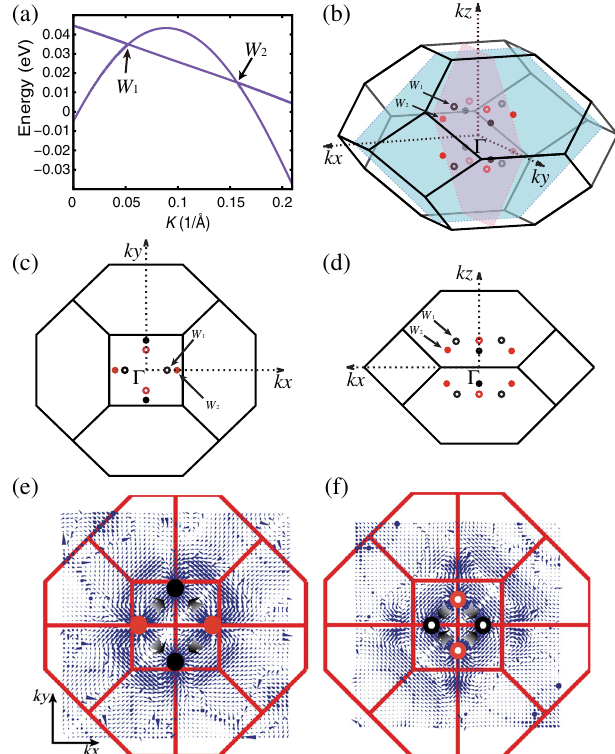
FIG. 3. (a) The energy dispersion along the direction connect- ing W 1 and W 2 . (b) Three-dimensional view of the eight pairs of WPs in the BZ. (c) Top view from [001] and (d) side view from [010] directions for the WPs. The hollow and solid dots represent WPs in the W 1 and W 2 groups, respectively. (e) The distribution of Berry curvature for the k z ¼ 0 . 139 Å − 1 plane. (f) The dis- tribution of Berry curvature for the k z ¼ 0 . 227 Å − 1 plane. The black and red dots denote the Weyl points with negative and positive chirality, respectively.